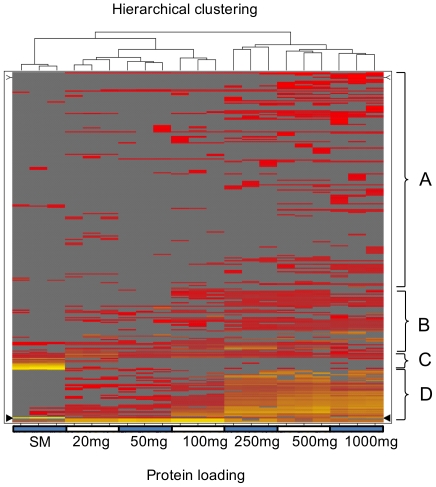
Global analysis of protein equalization.Prospectrum II beads were exposed to very high levels (up to 1000 mg protein/20 mg beads) and bound proteins were analyzed by quantitative label-free LC-MS. All quantitative data were expressed as heat diagrams (from red, low abundance to yellow, high abundance; grey: protein absent), arranged according to hierarchical (unweighted average) clustering of samples and K-means (data centroid based search initialized) clustering of the individual protein behaviors. Both clustering methods utilized Euclidian distance methods to assess similarity. The readily discernible classes of behaviors (labeled A ..D) are discussed in the text.